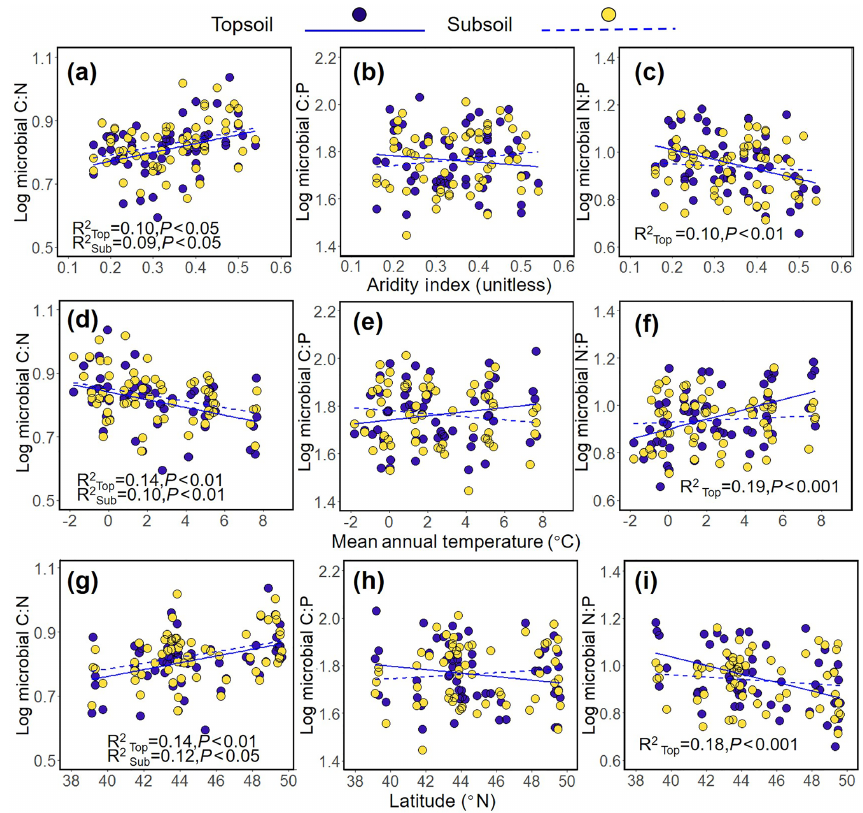
Figure 2. Relationships between the C:N, C:P, and N:P ratios in soil microbial biomass and aridity index (a–c) , mean annual tempera- ture (d–e) , and latitude (g–i) in the Inner Mongolian